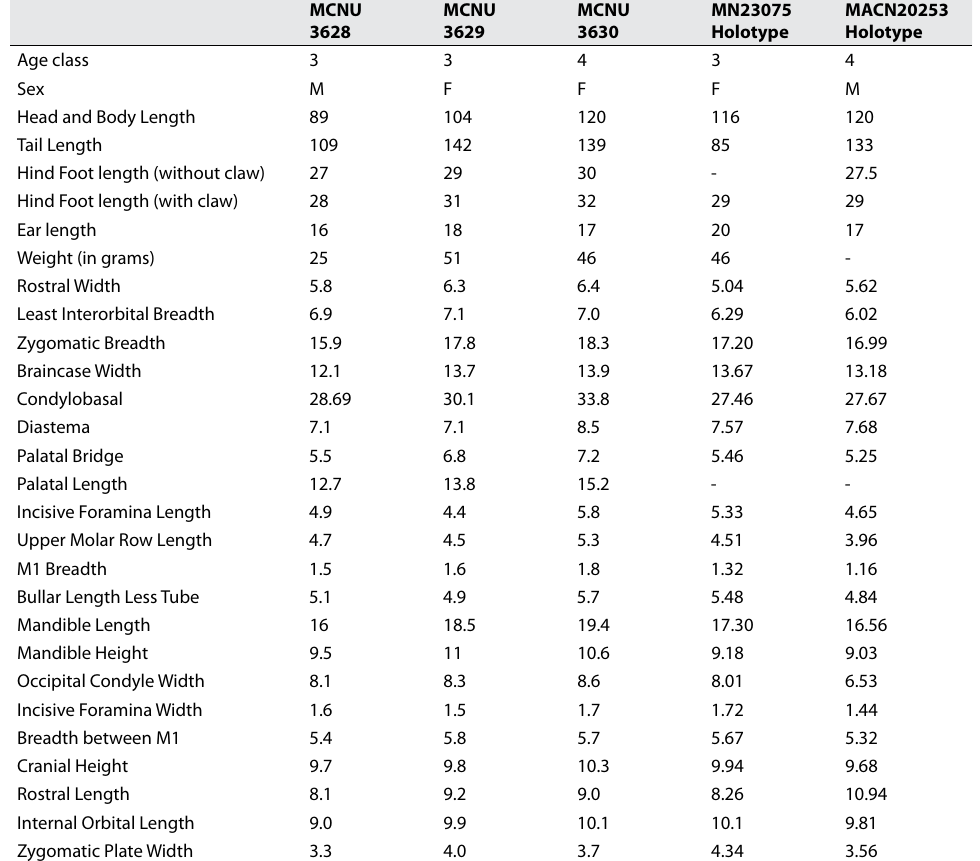
Table 1. External and craniodental measurements (in mm) of the three adult specimens of Abrawayaomys ruschii collected in Chapecó, Santa Catarina state, Brazil. Cranial measurements were taken using digital photography. Also are presented the measures of the two holotypes: A. ruschii (MN23075) and A. chebezi (MACN20253), the latter measurements taken from Pardiñas et al. (2009). Age class following toothwear classes proposed by Patterson